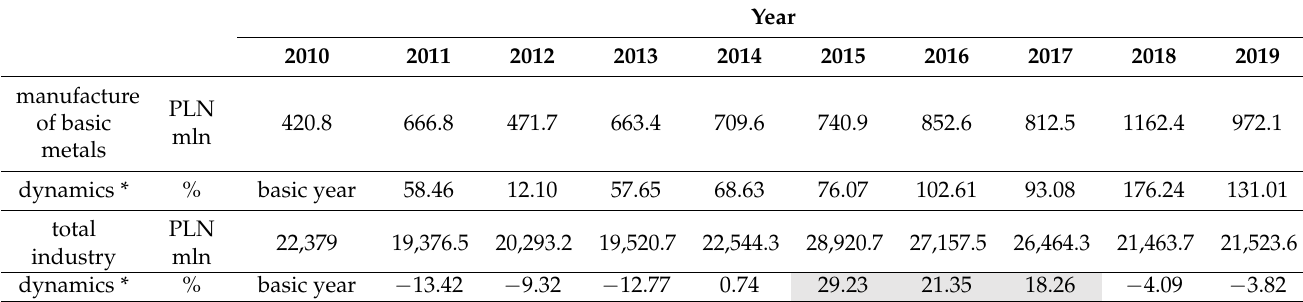
Table 6. Innovation from 2010 to 2019—expenditures and dynamics for basic year